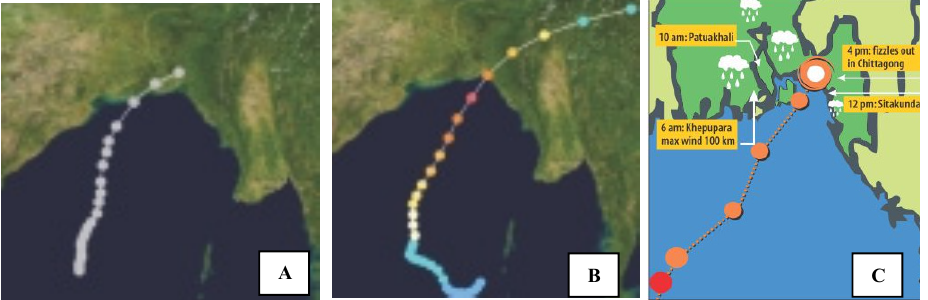
Figure 5. The routes of cyclones in the Bay of Bengal and landfall in Bangladesh: ( A ) 11 November 1970, wind speed 205 km/h at Bhola; ( B ) 29 April 1991, wind speed 260 km/h at Chittagong and ( C ) 16 May 2013, wind speed 100 km/h “Mahasen” at Chittagong, Bangladesh. Source: The Daily Star